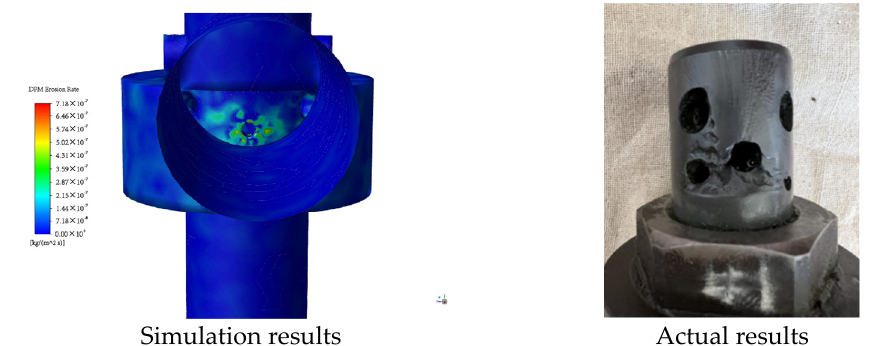
Figure 9. Comparison of the simulation results and the actual